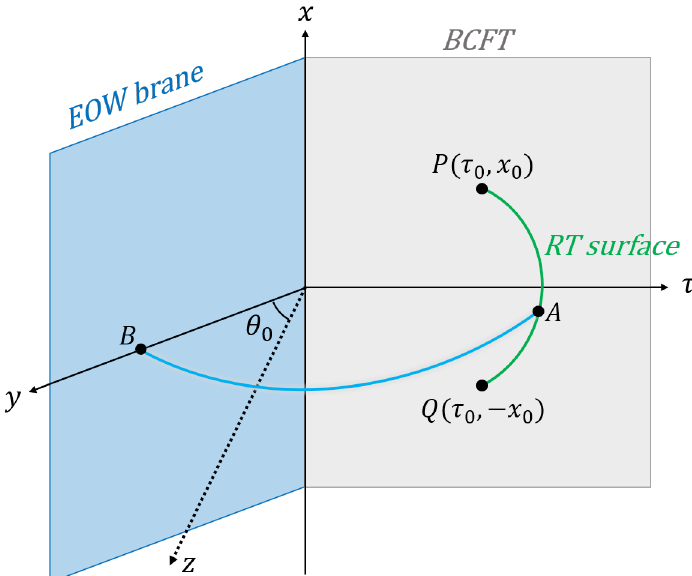
Figure 14. The connected phase in terms of ( τ, x, z ) coordinates. The extremal surface (RT surface) is mapped to the green arc which lies in a plane perpendicular to the BCFT plane. The wedge cross section is represented by the blue arc, which is the minimal geodesic that connects the EOW brane and the RT